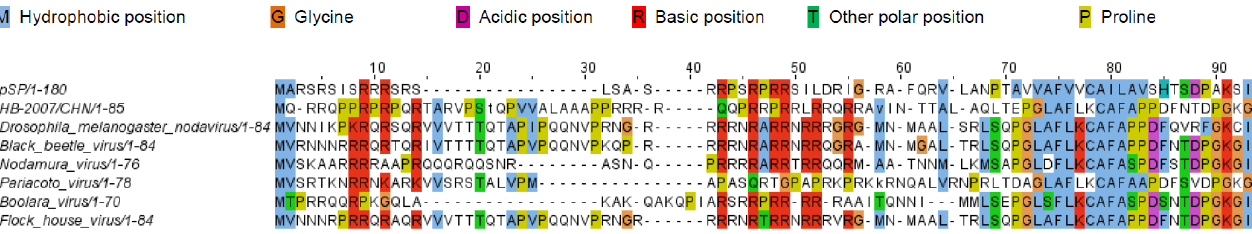
Figure 4. The N-terminal region of CBPV pSP and several alphanodaviruses. Similarities were detected using HHpred, edited manually and visualized using Jalview [30].